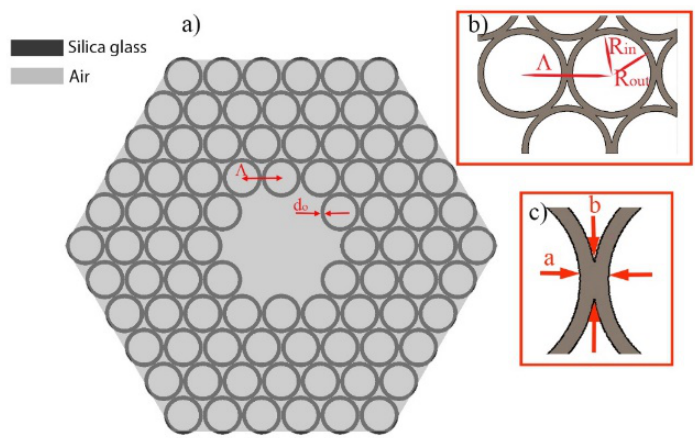
Figure 1. ( a ) Cross section of the designed Kagomé hollow-core fiber, ( b , c ) Depicted details of the construction: R in , R out , a , b —inner and outer radiuses of the glass capillaries, and dimensions of the struts, respectively.